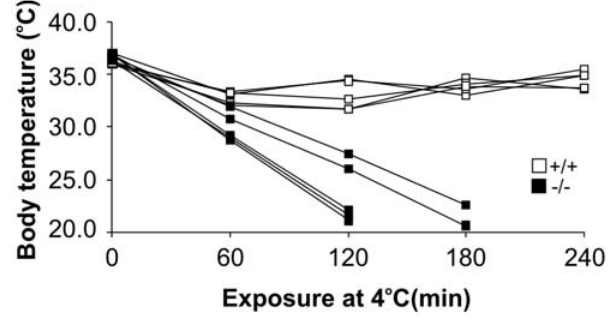
Figure 9. Changes in body temperature during cold exposure with prior fasting. Cold tolerance was tested after 20 h of fasting by exposing individually housed wild type mice (open boxes) and Decr 2 / 2 mice (solid boxes) to a + 4 u C environment for a maximum of 4 hours or until body temperature dropped below 25 u C. Temperature was measured from the shaved mid-dorsal body surface using an infrared thermometer. At each time point, body temperatures are presented as mean values of three measurements from the same